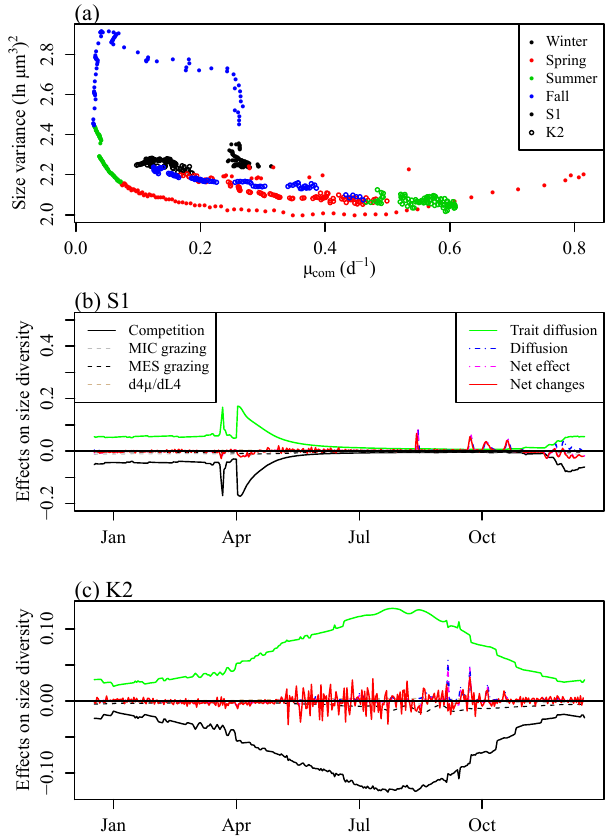
Figure 12. (a) Scatterplots of size variance versus phytoplankton community growth rate ( µ com ) . (b) Contributions of various factors to the dynamics of size variance in surface waters at S1. The term 2 µ “competition” equates to v 2 d . MIC and MES grazing equates d l 2 2 g i 4 µ to − v 2 d , “d4 µ/ dL4” equates to v 2 u d , and “trait diffusion” d l 2 d l 4 equates to 2 uµ . All the derivatives are evaluated at the mean size. “Diffusion” means the contribution to the changes in size variance induced by diffusion with the underlying grid. “Net effect” means the sum of the above terms. “Net changes” mean the difference in size variance between adjacent days. (c) The same as (b) , but at station